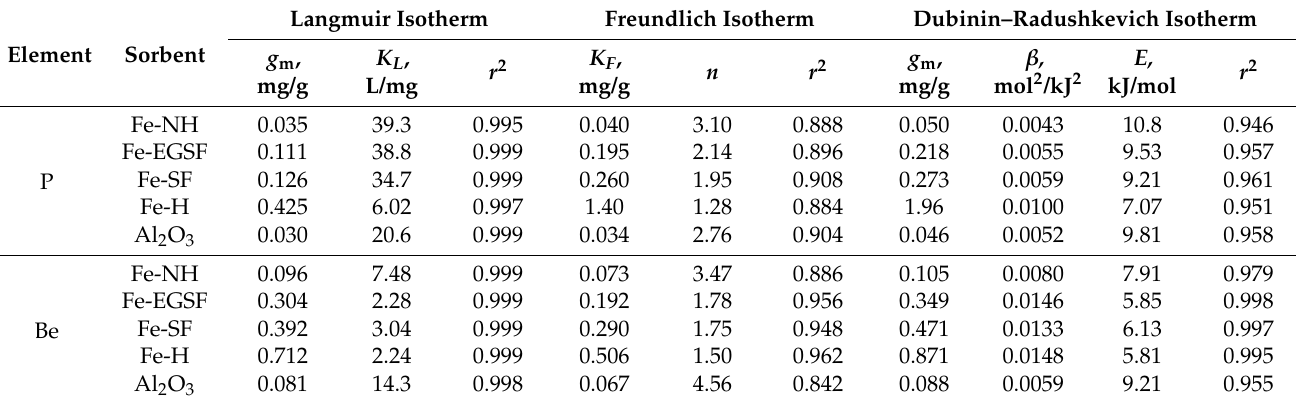
Table 4. The obtained parameters of the sorption